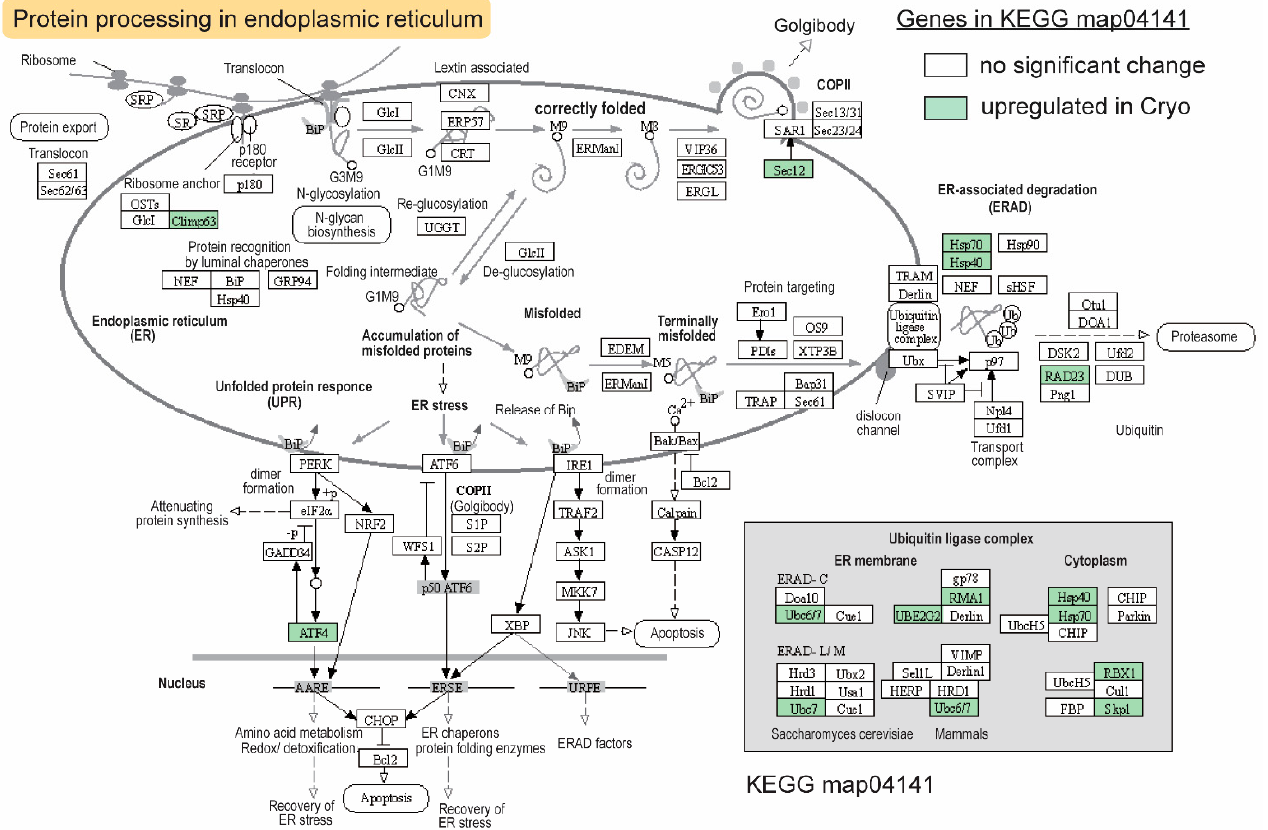
Figure 6. Effects of cryopreservation of sperm on protein processing in the endoplasmic reticulum (map04141) in the blue catfish, Ictalurus furcatus . Upregulated genes, proteins, and enzymes were highlighted in green.